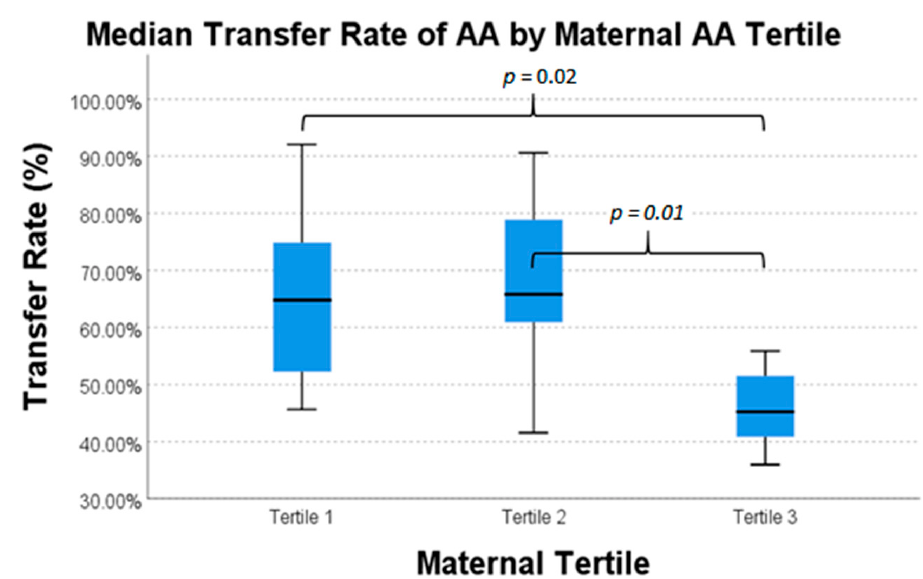
Figure 1. Median transfer percentage of arachidonic acid (AA) across tertiles of maternal plasma AA concentration.